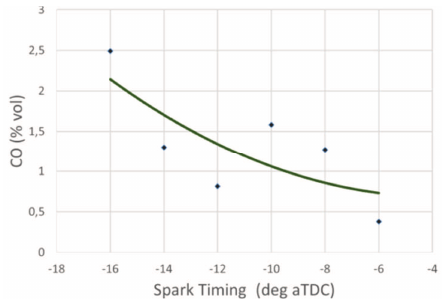
Fig. 7. CO emission as a function of the spark timing